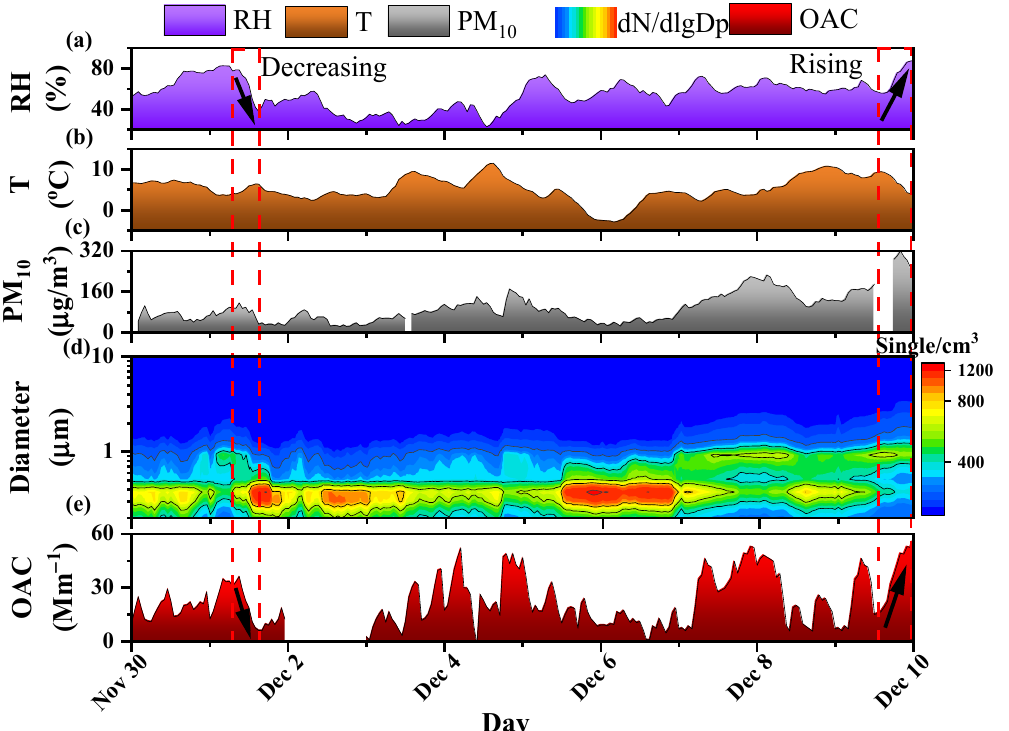
Figure 6. Highly time-resolved evolution of two selected RH-change episodes (red dotted box). ( a ) RH ; ( b ) T ; ( c ) PM 10; ( d ) particle number size distribution; ( e ) OAC. A process of increasing and decreasing relative humidity was selected to clearly show the evaluation of particle size and aerosol optical absorption coefficient.